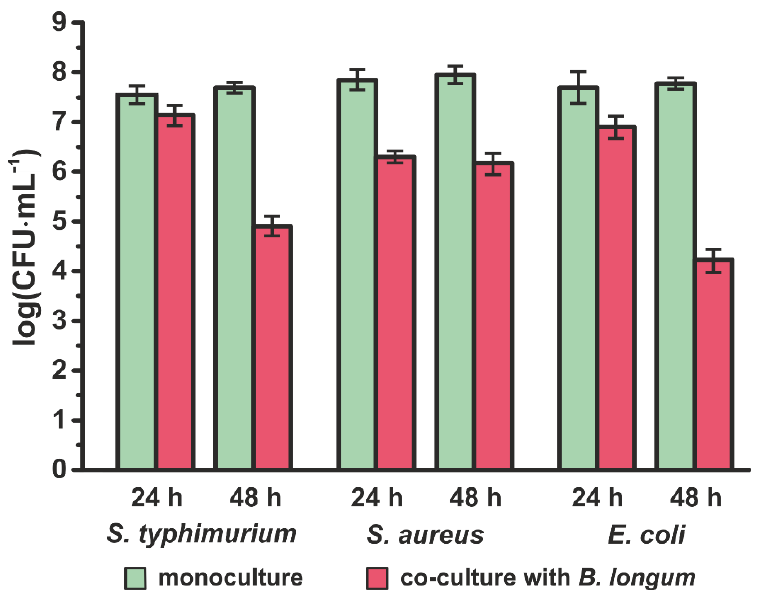
Figure 2. The growth inhibition of S. typhimurium NCTC-00074, S. aureus ATCC-6538, and E. coli ATCC-25922 upon co-cultivation with B. longum MC-42.